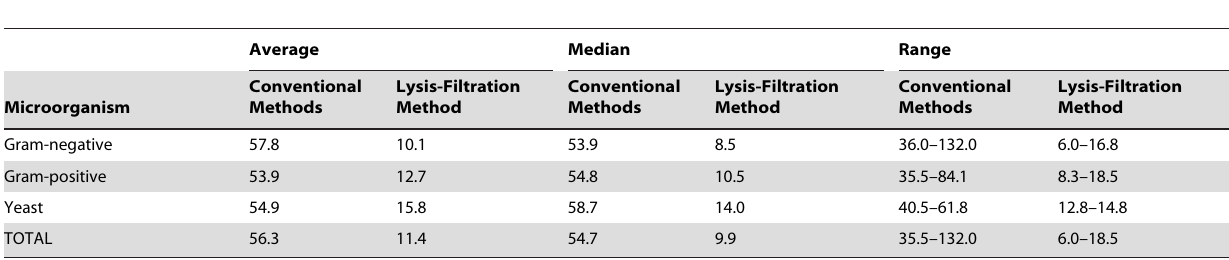
Table 3. Comparison of time to ID and AST between Lysis-Filtration method and conventional methods (hours) a